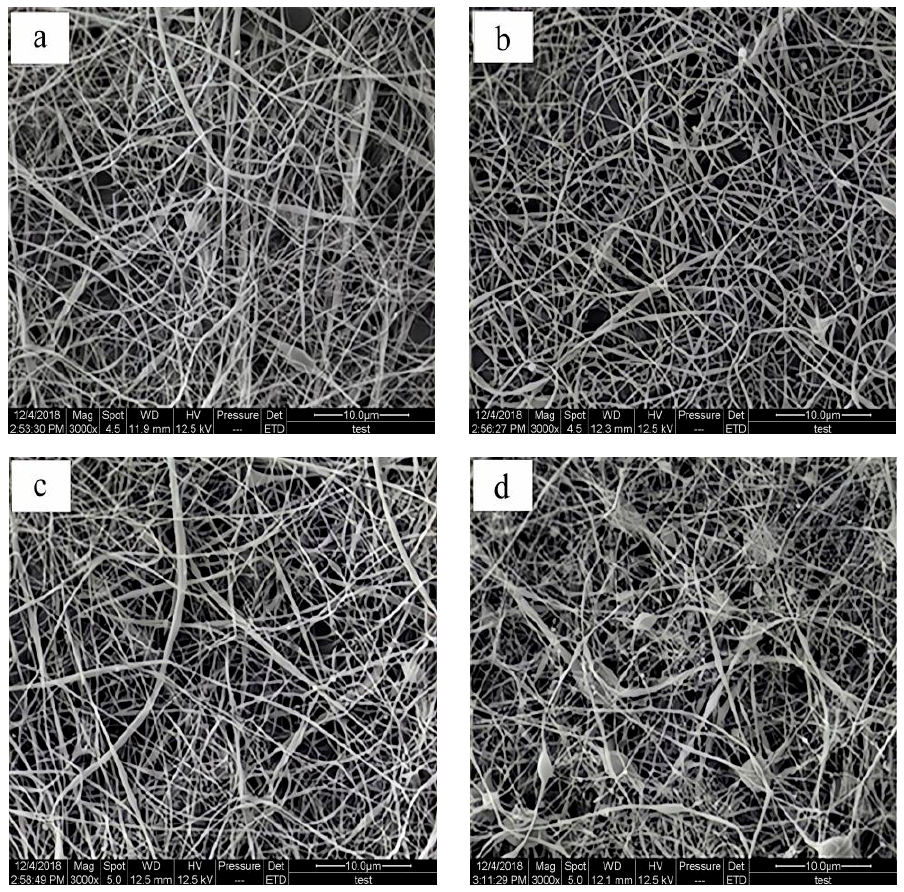
Figure 8. SEM images at different addition of AgNO 3 : ( a ) the addition of 0.1 wt%; ( b ) the addition of 0.3 wt%; ( c ) the addition of 0.5 wt%; ( d ) the addition of 0.7 wt%.